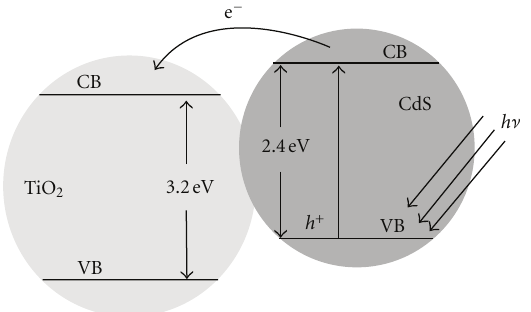
Scheme 1: Illustration of electron transfer between CdS and TiO 2 in the CdS-TiO 2